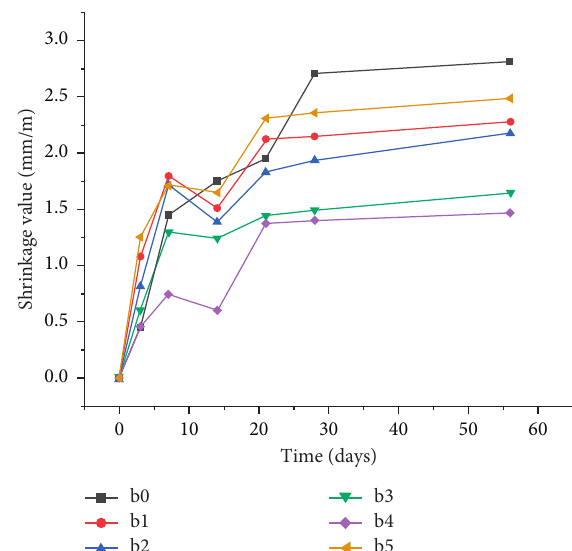
Figure 3: Effect of curing age on the shrinkage values of the FC specimens with different contents of